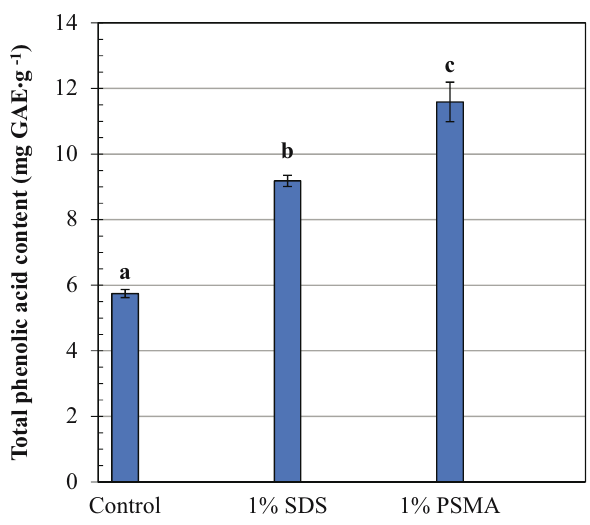
Figure 3: Comparison of the total phenolic acids in robusta co ff ee leave extracts obtained by di ff erent extracting systems. Mean values followed by the same letter in a bar chart plot are not signi fi cantly di ff erent at p < 0.05, according to the Duncan ’ s multiple range